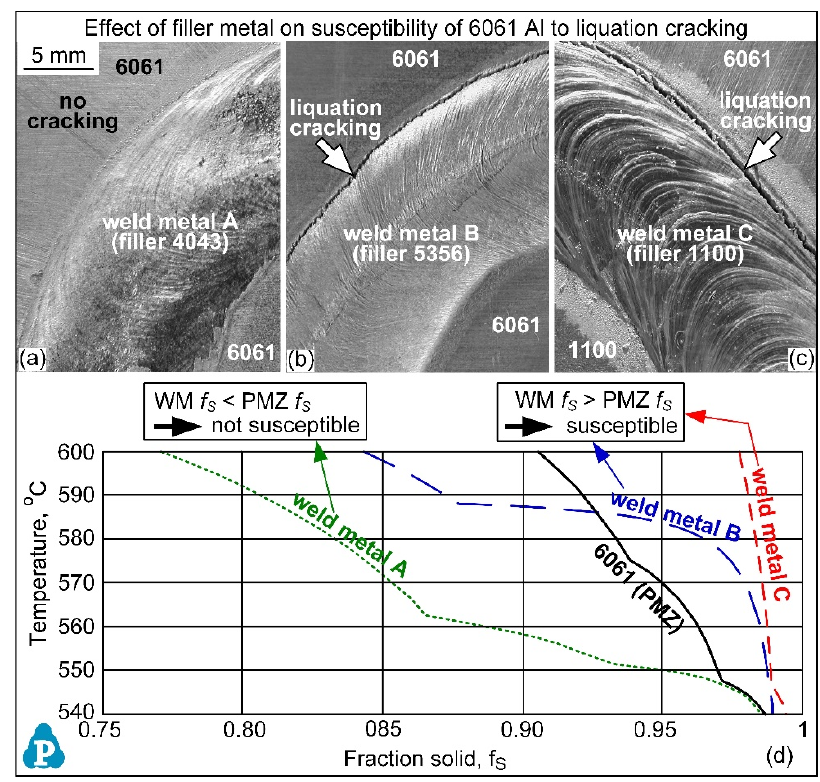
Figure 4. Effect of filler metal on liquation cracking in circular-patch test of 6061 Al (Al-1Mg-0.6Si): ( a ) filler 4043 Al (Al-5Si), weld metal A Al-2.146Si-0.631Mg-0.253Cu-0.064Mn-0.066Zn (67.6% dilution); ( b ) filler 5356 Al (Al-5Mg), weld metal B Al-2.376Mg-0.526Si-0.183Cu-0.063Mn-0.068Zn (64% dilution); ( c ) filler 1100 Al (pure Al), weld metal C Al-0.203Mg-0.225Si-0.122Cu-0.023Mn-0.022Zn (8.7% dilution from 6061 Al outer piece and 43.8% from 1100 Al patch); ( d ) T - f S curves for PMZ and weld metals.